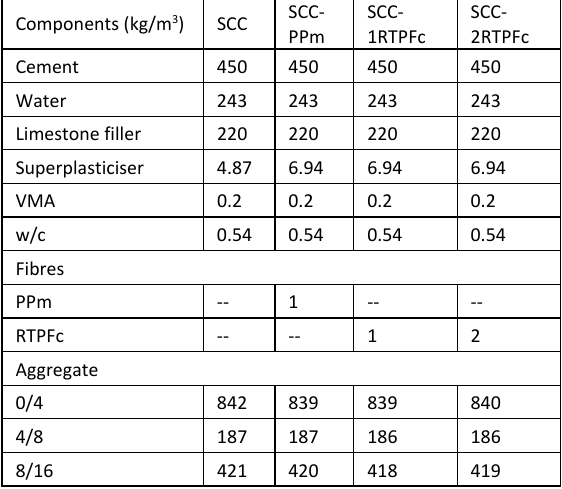
Table 2. Concrete mix design.